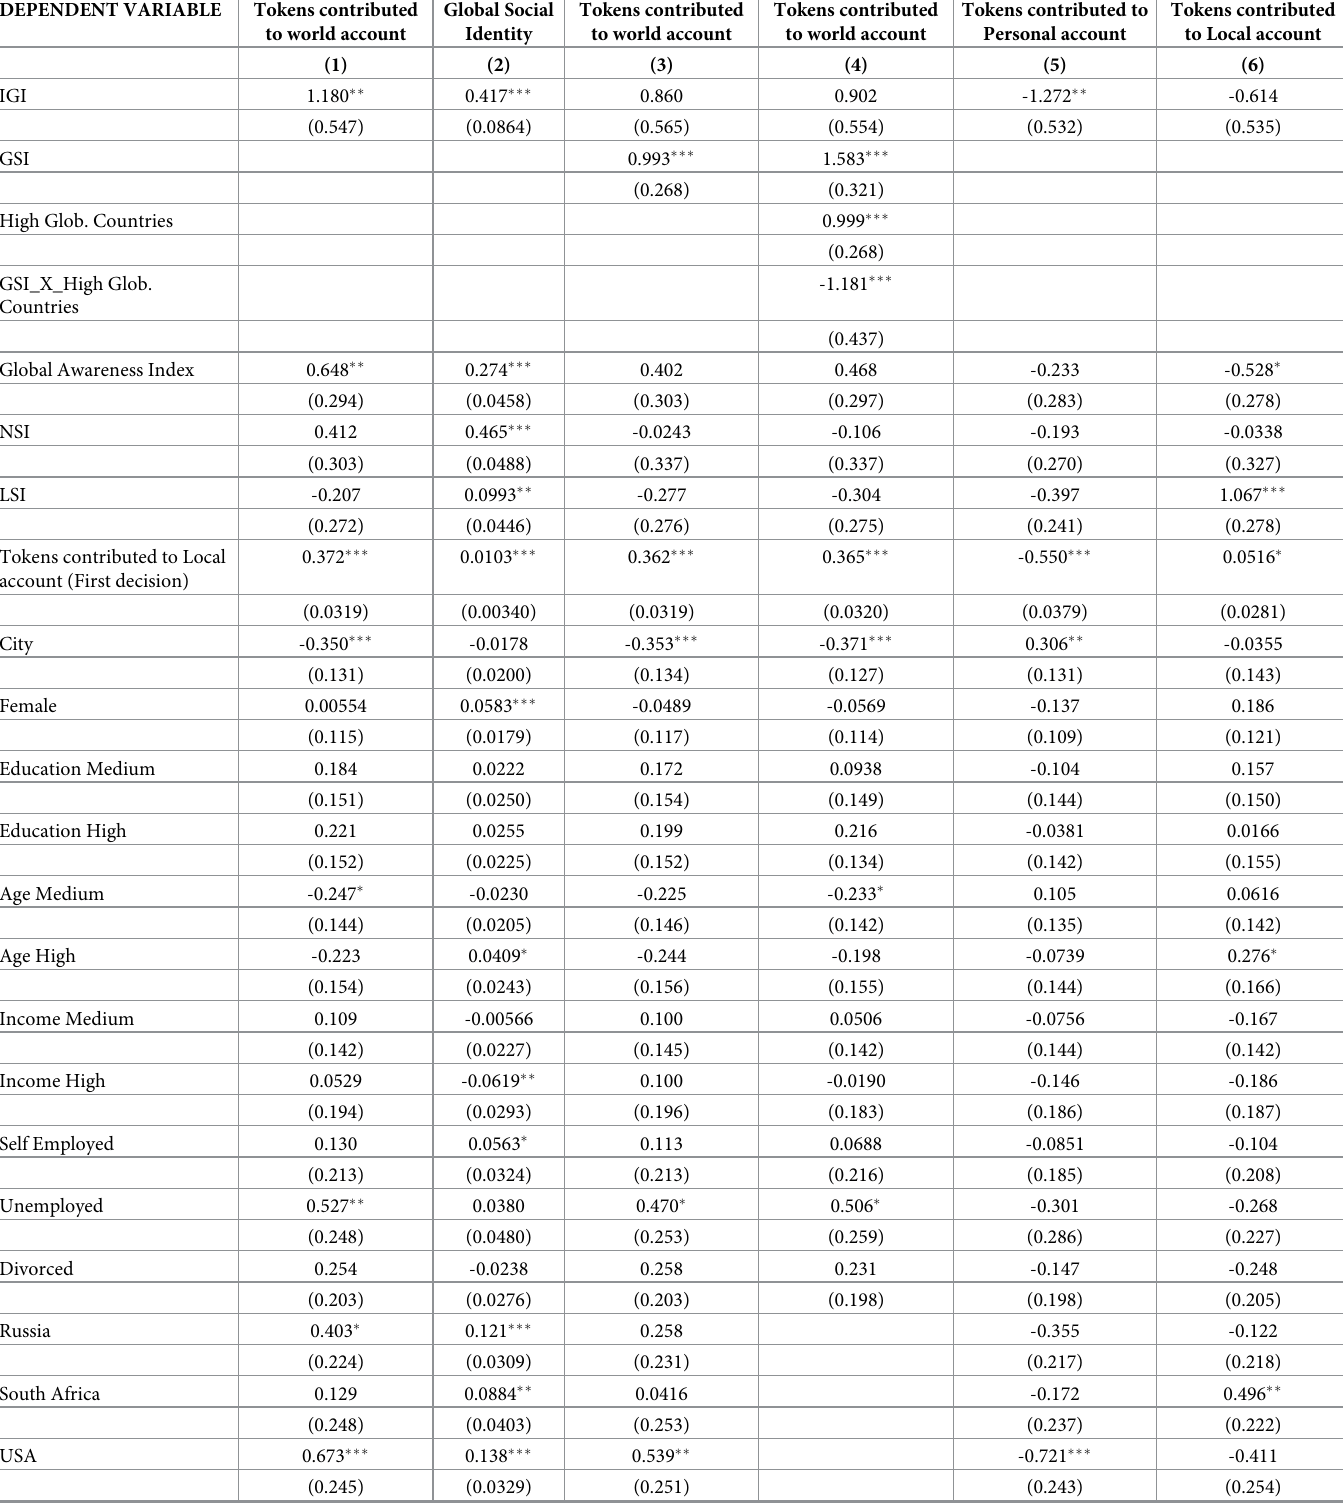
Table 2. Regression analysis of mediating effect of GSI between IGI and World-level cooperation. DEPENDENT